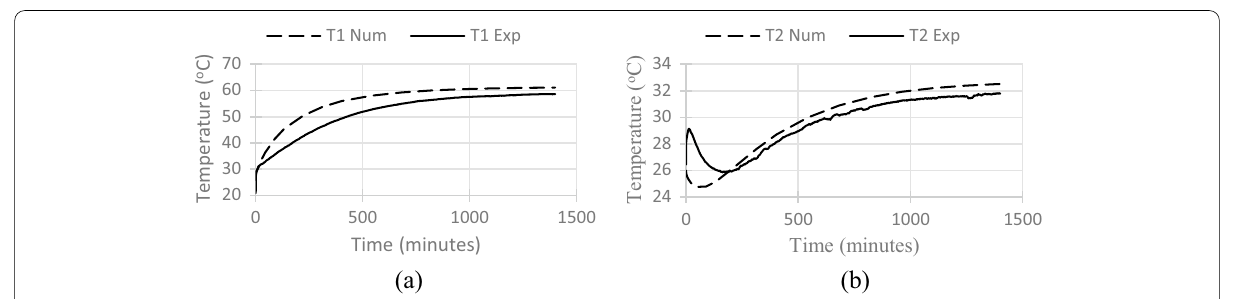
Fig. 9 Experimental and numerical temperature profiles for the control panel (P0), a cold and b hot